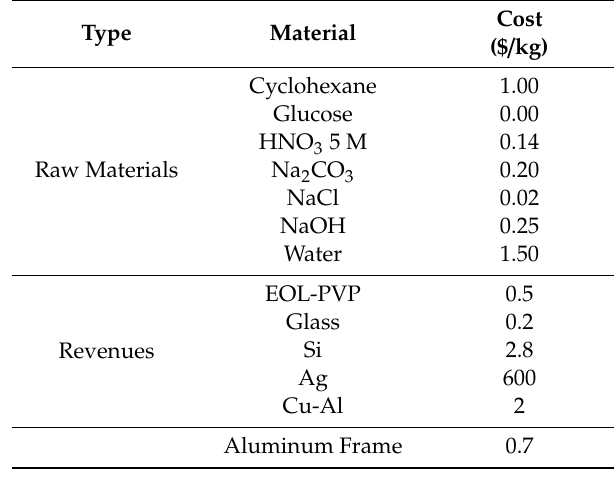
Table 8. Purchasing prices of raw materials and selling prices of